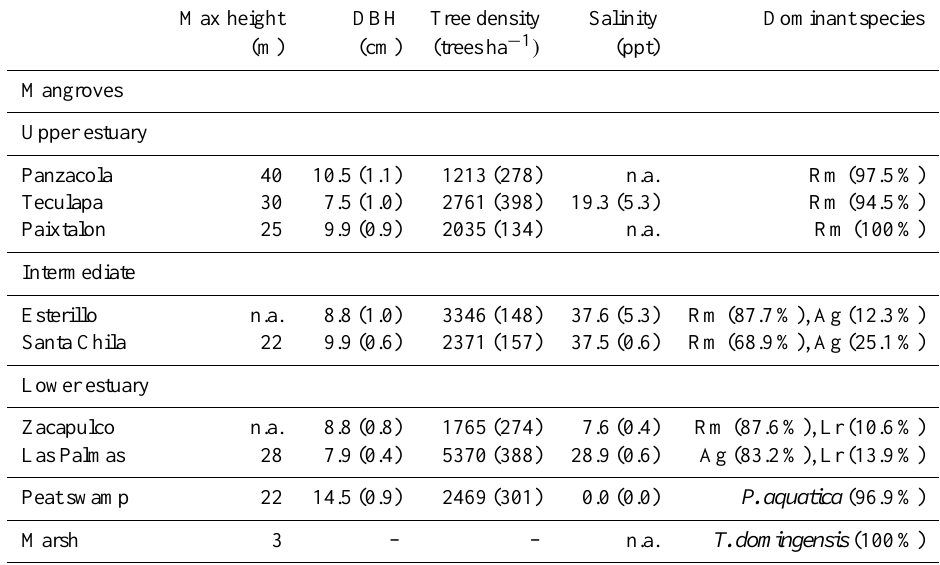
Table 1. Characteristics of sampling sites within La Encrucijada Biosphere Reserve. Values are shown as mean (standard error). Max – maximum; DBH – diameter at breast height; n.a. – not assessed; Rm – Rhizophora mangle ; Ag – Avicennia germinans ; Lr – Laguncularia racemosa